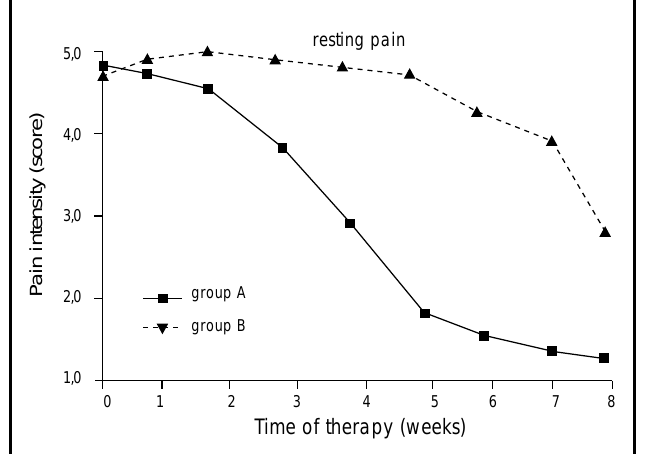
Figure 3: Development of oedema caused circum- ference increase over MCP in the course of the therapy